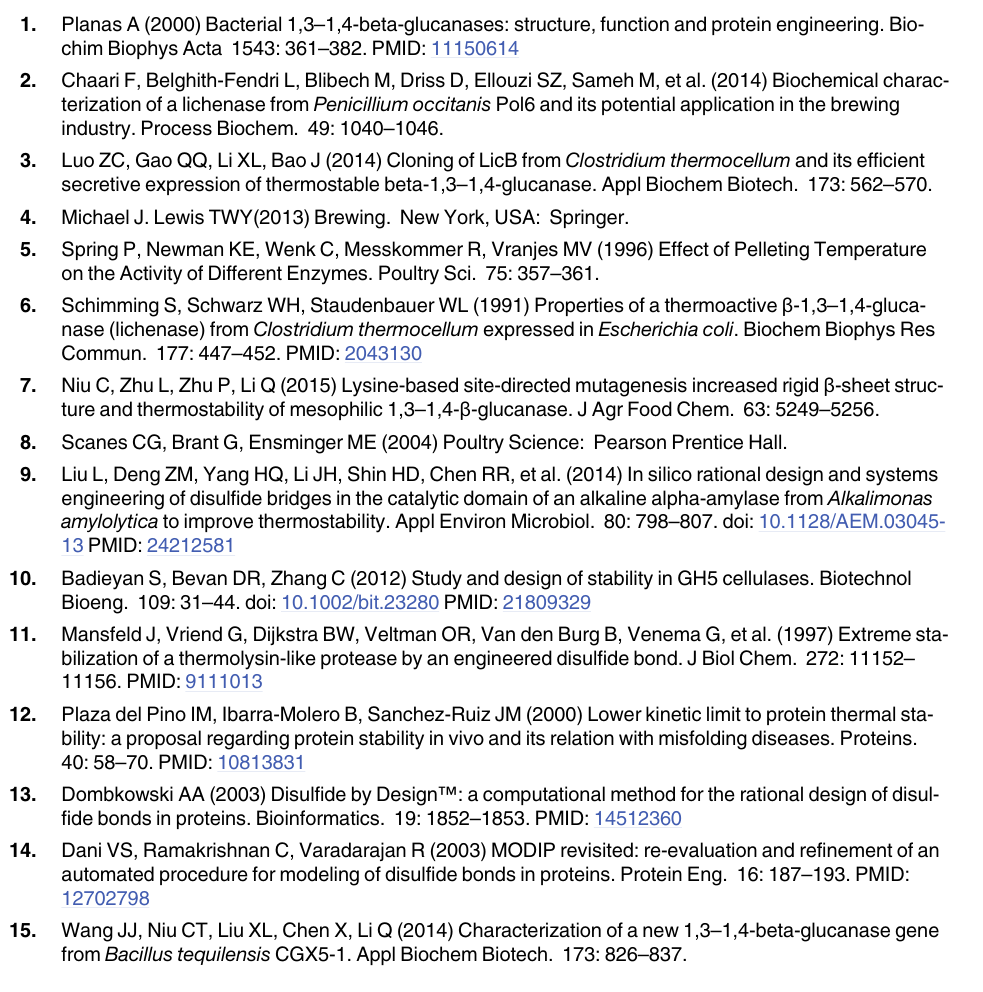
S4 Fig. The optimal pH (a) and pH stability of wild-type BglTM and the mutants with sin- gle-Cys substitution. (TIF) S5 Fig. Comparison of the 3D structures of wild-type BglTM and K83C-A141C mutant.